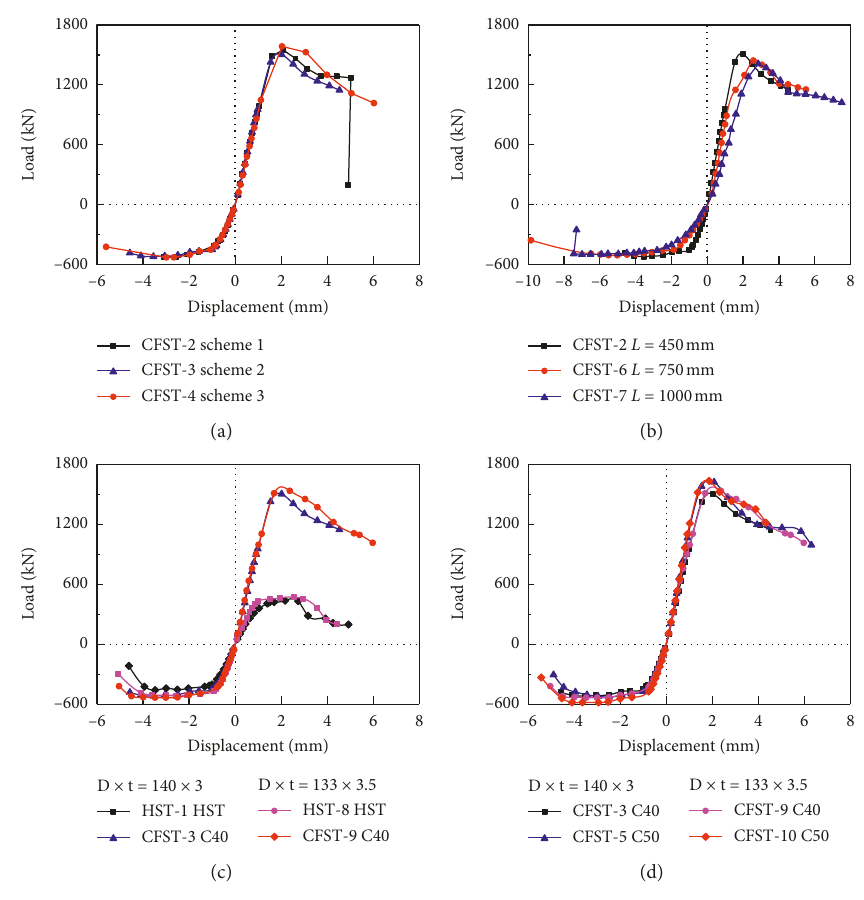
Figure 7: Envelope curves of